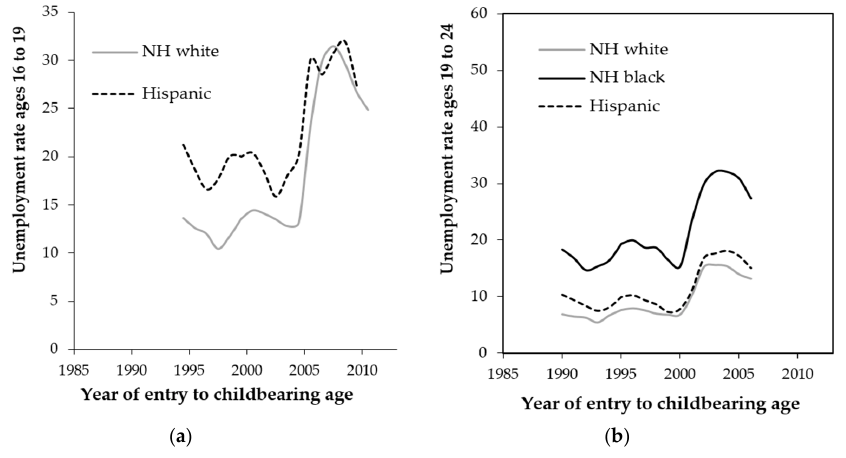
Figure 3. Unemployment rate for men and women ages ( a ) 16 to 19 and ( b ) 20 to 24 by year of entering into childbearing age and racial and ethnic groups. Source: